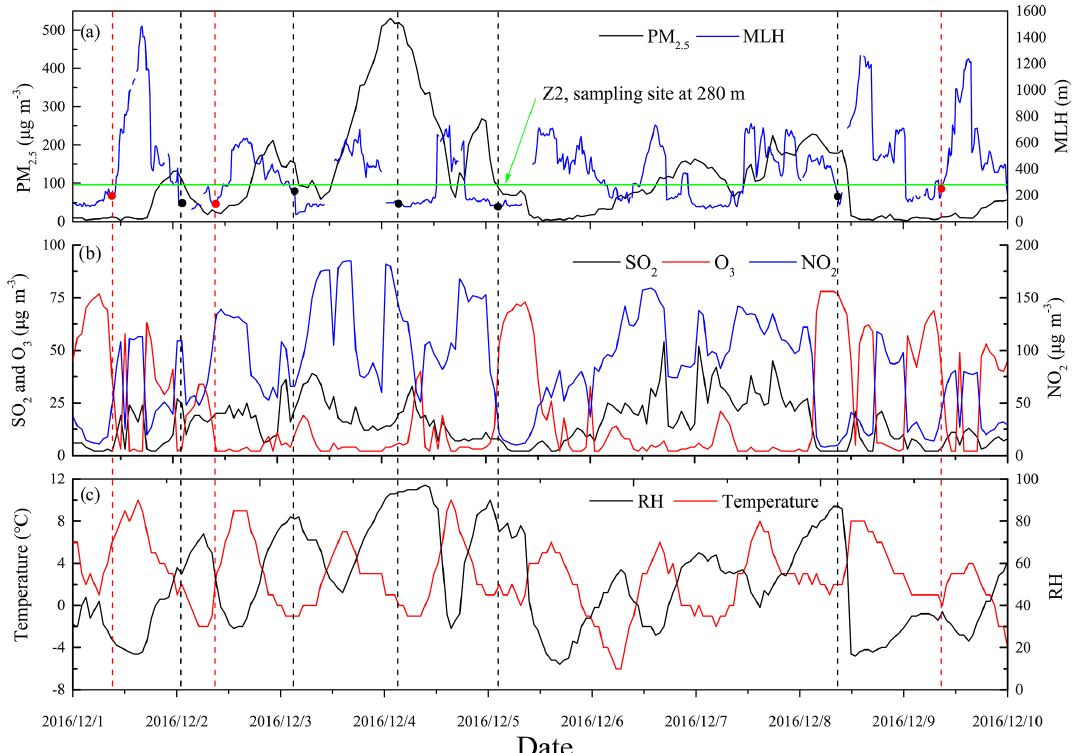
Figure 1. The dashed lines represent the individual-particle sampling times, with red lines representing non-haze samples and black lines haze samples. (a) Temporal variations in mixed-layer height (MLH) and PM 2 . 5 mass concentrations. The solid dots represent the MLH during the sampling times. (b) Temporal variations in SO 2 , NO 2 , and O 3 at ground level at the Olympic Park monitor site, which is the closest national air quality monitor station to the sampling site ( ∼ 1 . 5km). (c) Temporal variations in temperature ( T ) and relative humidity (RH) at ground level. The date was obtained from the Ministry of Ecology and Environment of China (https://www.aqistudy.cn, last access: 31 March